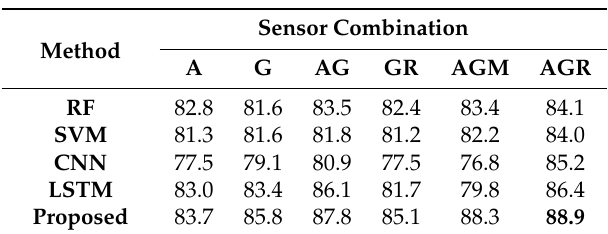
Table 3. Average testing accuracy achieved with two classical machine learning (ML) methods, and three DL methods, for six sensors combinations. LOSO evaluation (%). A—accelerometer, G—gyroscope, M—magnetometer, R—rotation vector